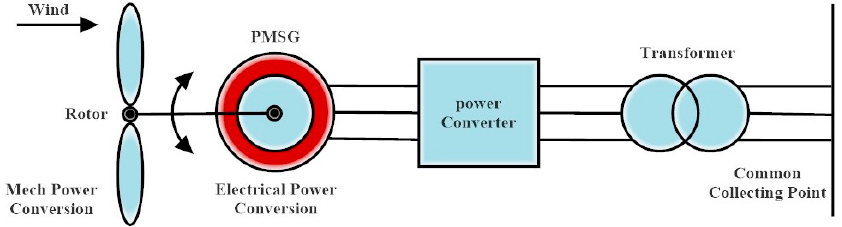
Figure 13. Wind energy conversion system for PMSG .